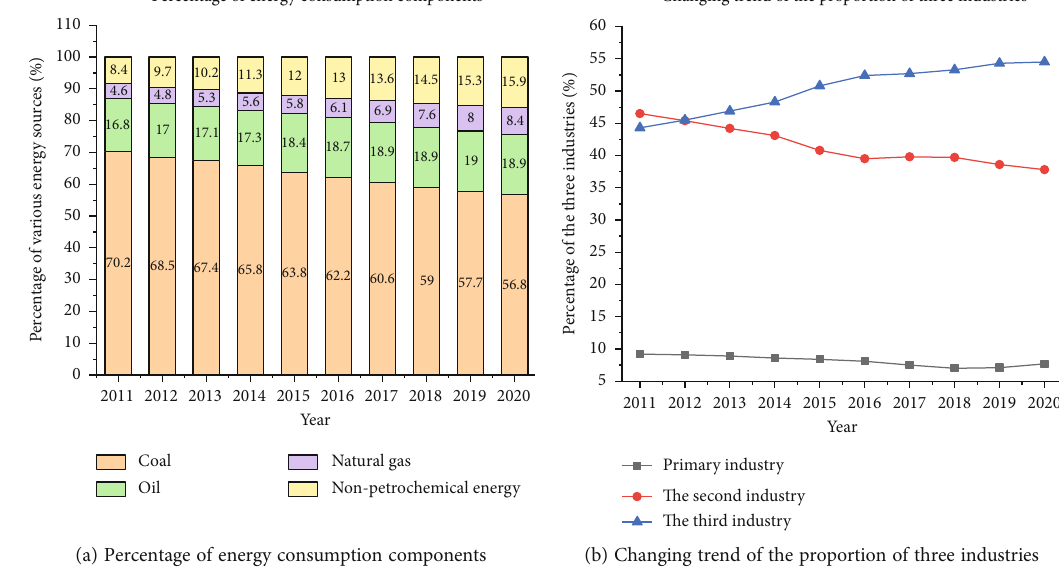
Figure 1: Distribution of China ’ s energy consumption and the proportion of three